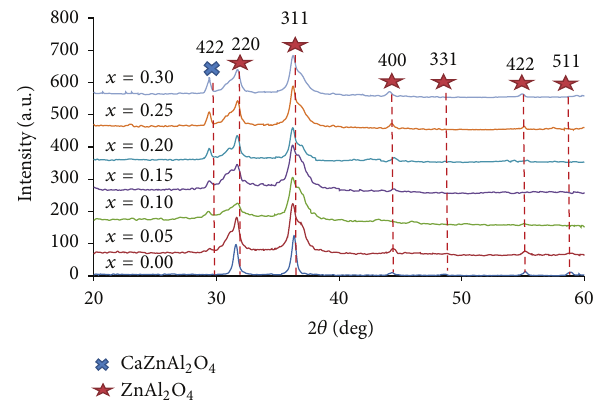
Figure 2: XRD patterns of Ca 𝑥 Zn (1−𝑥) Al 2 O 4 nanostructure annealed at 500 ∘ C for